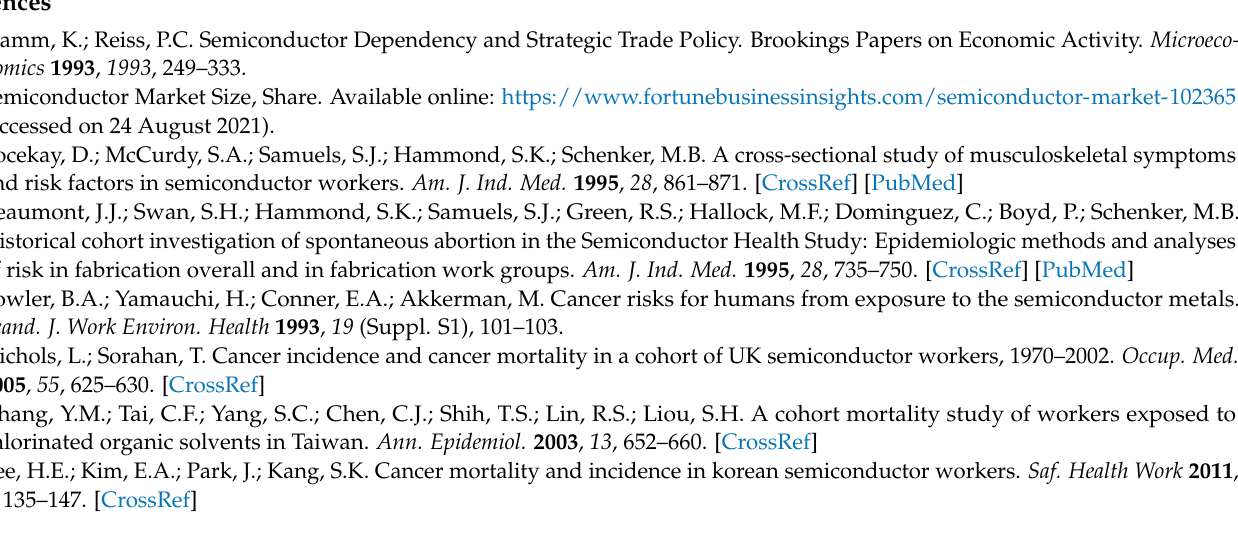
Figure S2: Usual semiconductor’s shift work pattern and considered sample collection protocol in semiconductor